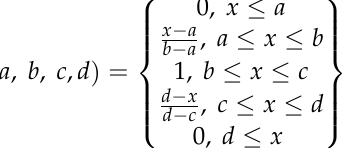
Table 5. Fuzzification of the range of variables in the PMM and PSM.